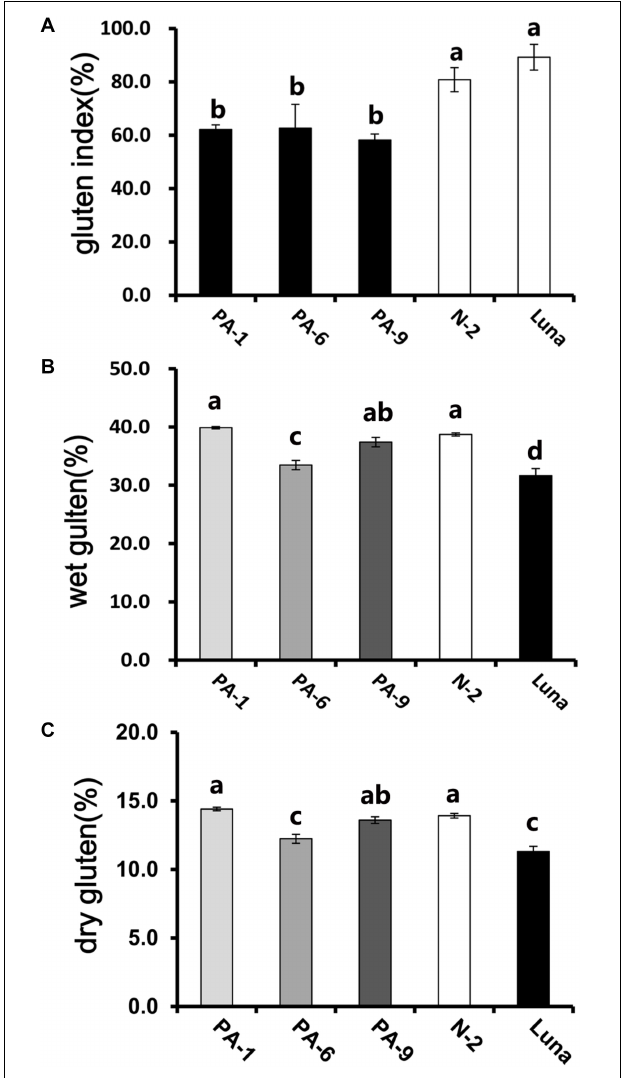
FIGURE 1 | Determination of gluten index of transgenic and control lines. (A) The wet gluten (B) dry gluten content, and (C) gluten index of transgenic and control lines. Data are given as mean ± SEM, calculated from three replicates. Values within the column followed by different letters indicate significant difference ( P <